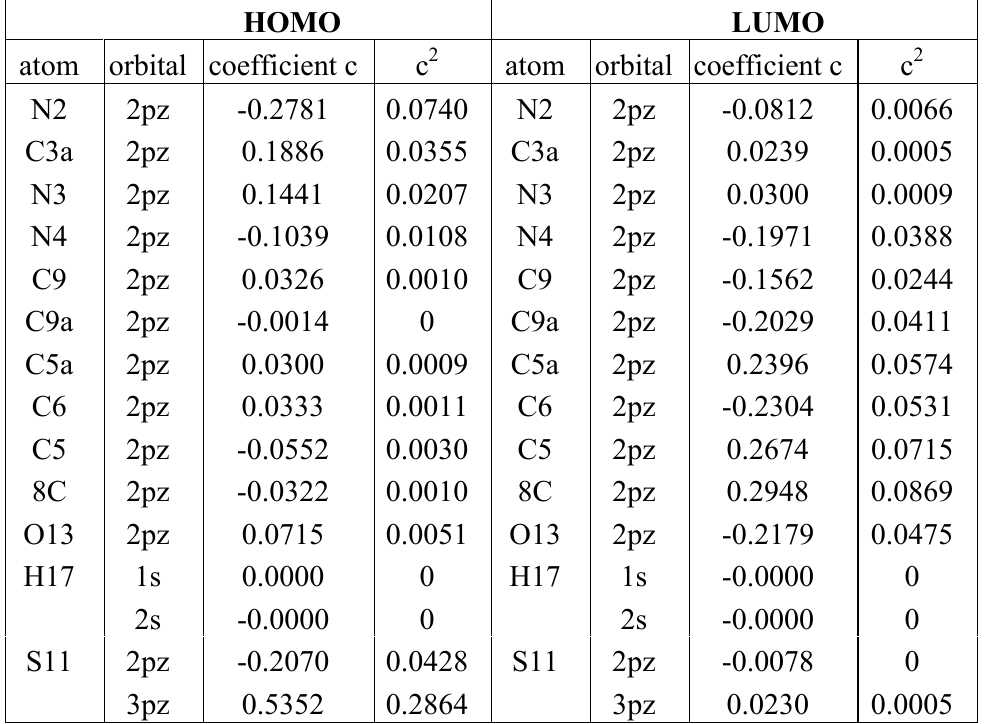
Figure1b. HOMO graphical representation of the anion form of 3. Table 1. The molecular orbital coefficient values of the anion form of 3 .